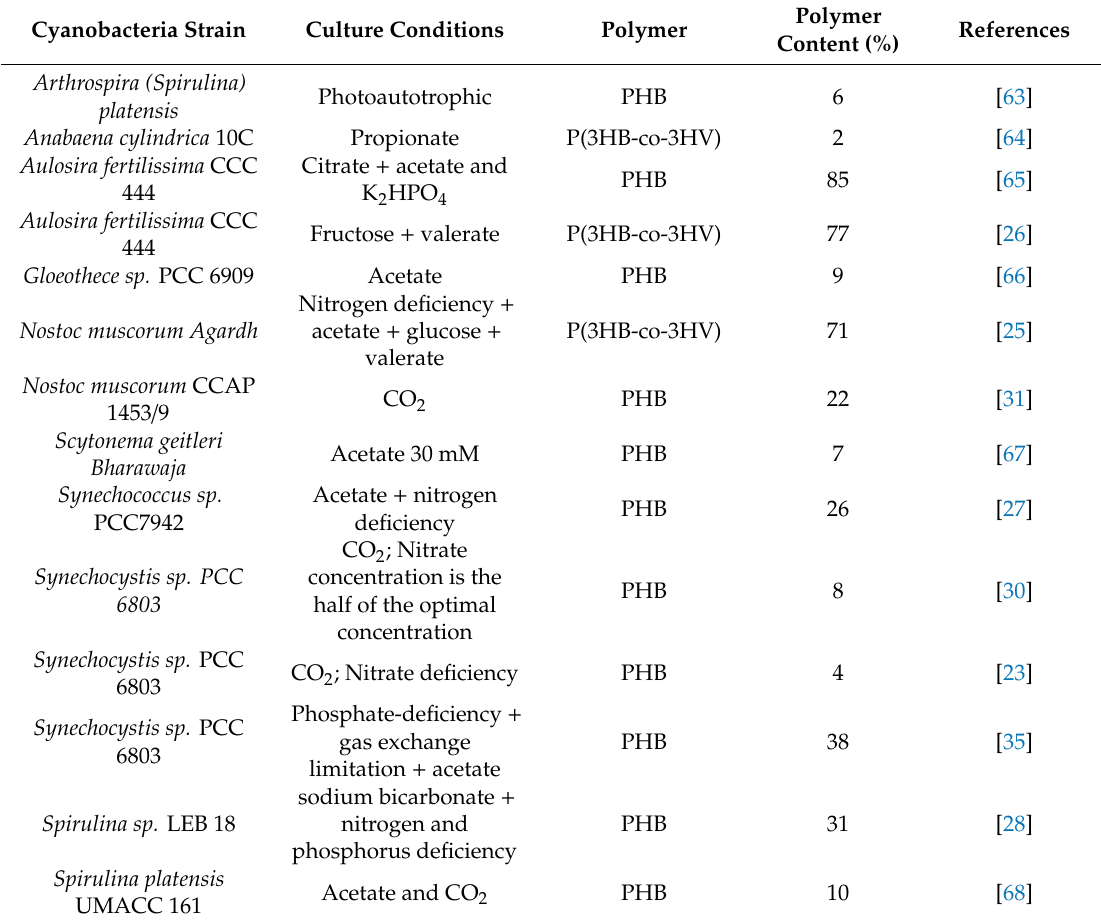
Table 4. Overview of cyanobacteria strains that produce